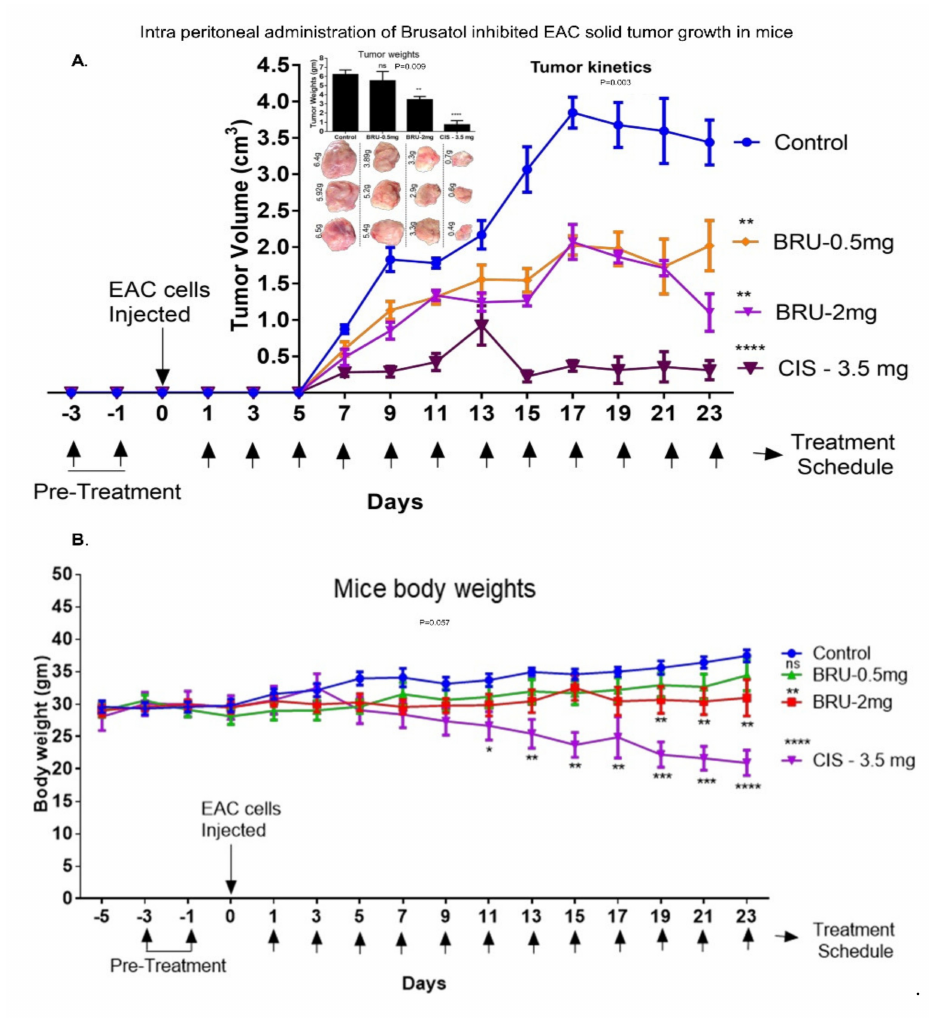
Figure 6. Intraperitoneal administration of Brusatol retarded EAC solid tumor growth in vivo. Swiss albino mice were engrafted with Nrf2 expressing EAC cells and treated with two different doses of brusatol (0.5 mg/kg and 2.0 mg/kg). ( A ) Brusatol (2.0 mg/kg) treatment decreased tumor growth significantly ( p value = 0.003; at day 23). Cisplatin (3.5 mg/kg) reduced tumor volume and tumor weight effectively. ( B ) Brusatol (0.5 mg/kg) administration did not induce significant changes in body weight ( p value = 0.05), although application of higher brusatol dose (2 mg/kg) resulted in decreased body mass after 17-day treatment. Cisplatin induced significant decreases in body mass after 12th day treatment ( p value = 0.01). One-way ANOVA test was used for the data analysis (* p < 0.05, ** p < 0.01, *** p < 0.005, **** p < 0.001). ns refers to